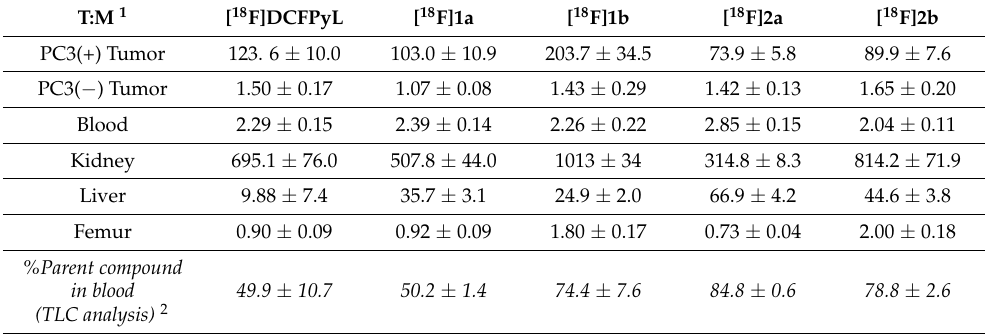
Table 2. Comparison of Tissue: Muscle ratios (T:M) of radioligands from PC3( − ) and PC3(+) xenografts at 60